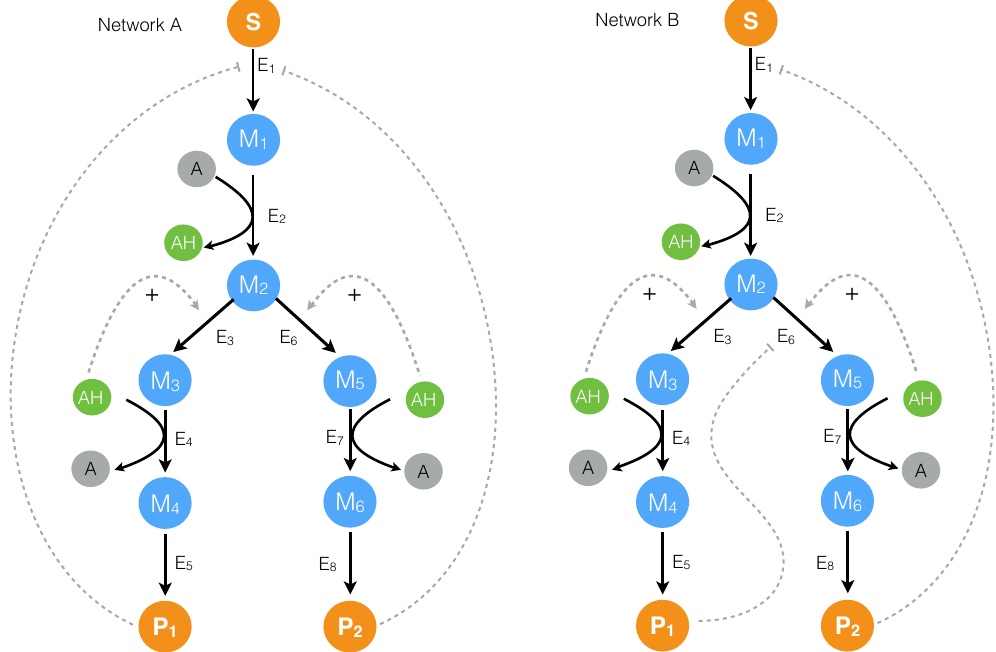
Figure 1. Proof-of-concept cell-free metabolic networks considered in this study. Substrate S is converted to products P and P through a series of chemical conversions catalyzed by 1 2 enzyme(s) E . The activity of the pathway enzymes is subject to both positive and negative j allosteric